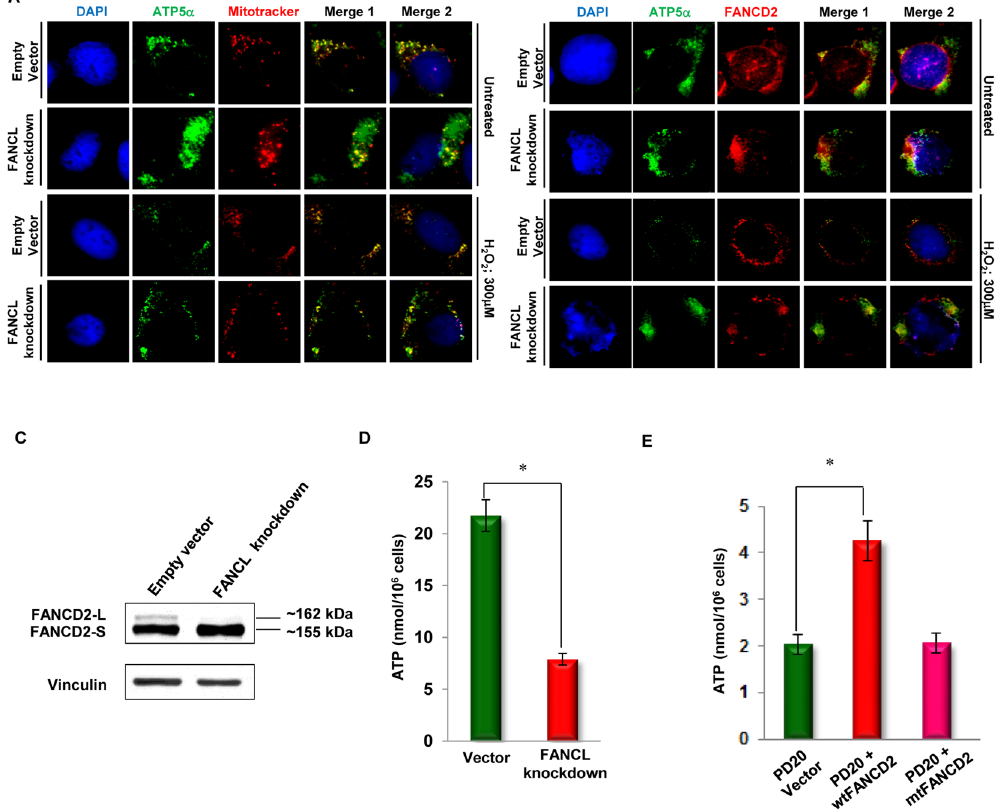
Figure 2. Cells carrying a compromised basal level of FANCD2 monoubiquitination harbor misplaced ATP5 α and a reduced amount of ATP. ( A ) Co-localization of mitochondria with ATP5 α protein in the control cells, but not in cells carrying silenced FANCL (a compromised basal level of FANCD2 monoubiquitination). U2OS stable cells carrying a normal basal level of FANCD2 monoubiquitination or a compromised basal level of FANCD2 monoubiquitination with or without H 2 O 2 treatment were incubated with MitoTracker Red CMXRos (red fluorescence) and goat anti-ATP5 α antibodies (green fluorescence) to identify the locations of the mitochondria and ATP5 α respectively. Confocal microscopy analysis was performed using appropriate filters for visualization of red, green, or combined fluorescence. The images were taken at a magnification of 600X. ( B ) Co-localization of wtFANCD2 protein with ATP5 α protein in the control cells, but not in cells carrying silenced FANCL (a compromised basal level of FANCD2 monoubiquitination). The same cells were incubated with anti-FANCD2 antibodies (red fluorescence) and goat anti-ATP5 α antibodies (green fluorescence) to mark their cellular locations respectively in the presence or absence of H 2 O 2 treatment. Confocal microscopy analysis was performed using appropriate filters for visualization of red, green, or combined fluorescence, and the images were taken at a magnification of 600X. ( C ) Conformation of the reduced basal level of monoubiquitnated FANCD2 in U2OS derivative cells harboring silenced FANCL (Supplementary Fig. 1C). FANCD2-L (Long form) is the monoubiquitinated form (about 162 kDa) and FANCD2-S (short form) is non-ubiquitinated form of FANCD2 protein (about 155 kDa) 52 . ( D ) ATP production in FANCD2 monoubiquitination-compromised cells was reduced compared to the control cells. Intracellular ATP production was measured by using the U2OS stable cell pair expressing FANCL at a normal or silenced level, in which the basal level of FANCD2 monoubiquitination was at the normal or low levels accordingly (Supplementary Fig. 1C and Fig. 2C). ATP production was significantly higher ( p < 0.005) in the control cells compared to FANCL-silenced cells carrying a low basal-level of monoubiquitinated FANCD2. 1 × 10 6 cells were lysed and intracellular ATP was determined with a colorimetric/fluorometric assay kit. ( E ) ATP production was low in PD20 cells (FANCD2 − / − ) stably expressing mtFANCD2 K561R or carrying the empty vector (control), compared to those cells carrying wtFANCD2. PD20 derivative cells were established, carrying wtFANCD2, mtFANCD2 or empty vector for control respectively (Supplementary Fig. 2). Intracellular ATP content was determined via the same kit used above ( C ). 1 × 10 6 cells were lysed, and intracellular ATP content was determined. There is a significant reduction in the production of ATP in mtFANCD2-carrying cells or control cells compared to wtFANCD2- carrying PD20 cells ( p <